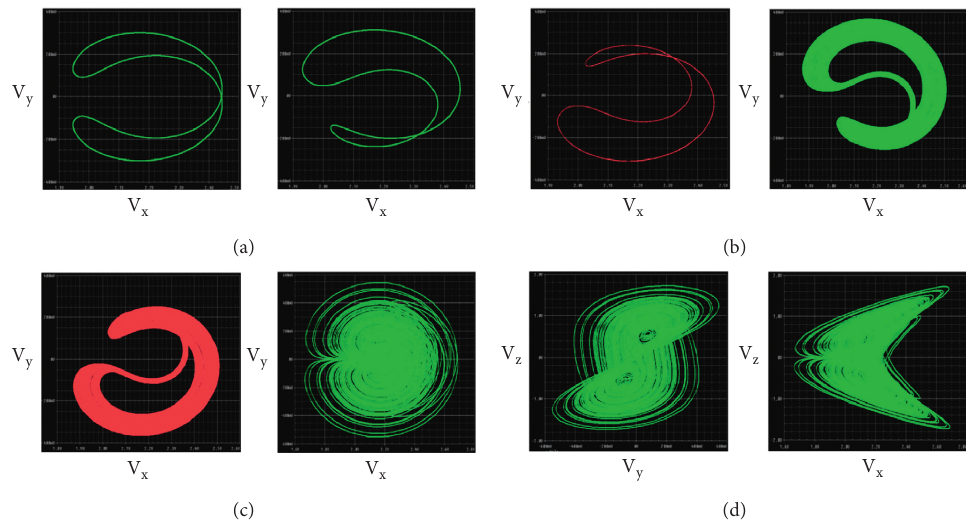
Figure 8: Phase planes of the dynamical behaviors of circuit in Figure 7 observed on the Pspice oscilloscope for specific values of R R � 6 . 67 k Ω , (b) R 6 R